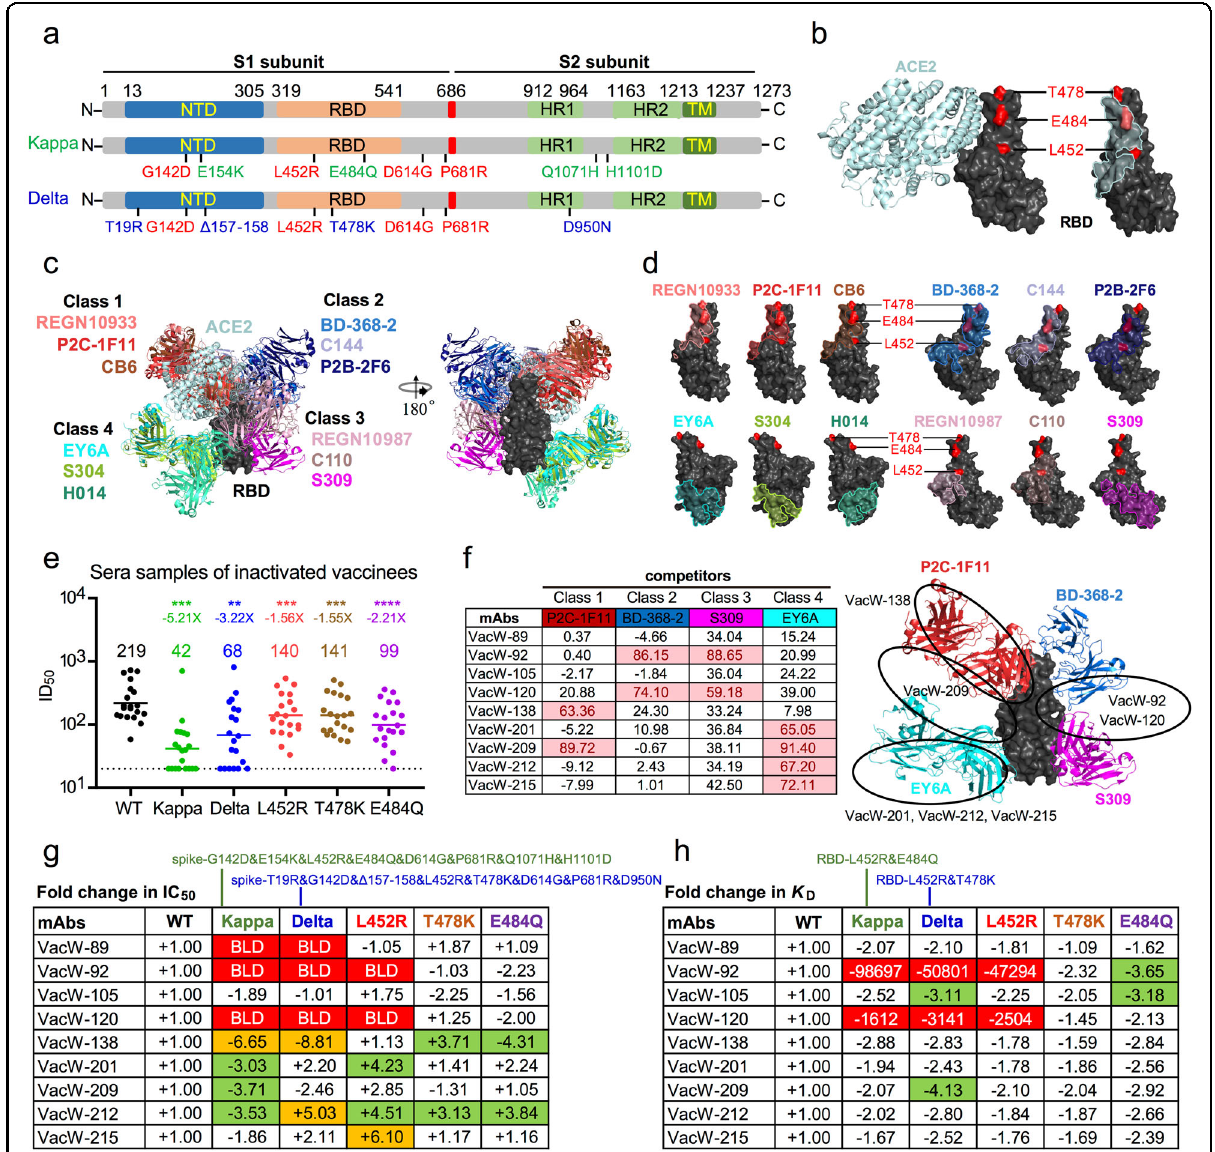
Fig. 1 Neutralization of SARS-CoV-2 Kappa and Delta variants by inactivated vaccine-elicited serum and monoclonal antibodies. a Mutations located in the viral spike proteins were identi fi ed in the Kappa and Delta variants. Shared mutations in both were highlighted in red, unique mutations in Kappa were marked in green, and mutations in Delta were in blue. b Overall structure of ACE2 in complex with SARS-CoV-2 RBD (left) and footprint of ACE2 on the RBD (right). Three mutation residues (L452, T478, and E484) were shown in red on the RBD. c Structural depiction of ACE2 and representative nAbs from each class binding to the RBD. Class 1: P2C-1F11, REGN10933, CB6; Class 2: BD-368-2, C144, P2B-2F6; Class 3: S309, C110, REGN10987; Class 4: EY6A, S304, H014. d Footprints of four classes of representative nAbs on the RBD. Three mutation residues (L452, T478, and E484) were shown in red on the RBD. e Changes in serum neutralizing titers of inactivated vaccine recipients against Kappa and Delta, as well as L452R, T478K, and E484Q variants, compared with WT. GMTs in ID 50 values were calculated and shown above each variant. ** P < 0.01, *** P < 0.001, **** P < 0.0001. f Competition ELISA (left) and predicted recognizing epitopes (right) of tested monoclonal nAbs binding to RBD with four representative nAbs. The values of competition measured in the highest concentration (10 μ g/mL) over 50% were highlighted in light red. g The fold change in IC 50 values of each monoclonal nAbs against mutant and WT viruses. h The fold change in af fi nity values in binding capacities of each nAb to mutant and WT RBD proteins. Data shown in e – h were means of two or three independent experiments. The changes shown in g , h between 3-fold and 5-fold were marked in green, between 5-fold and 10-fold were in orange. Below the limit of detection (BLD) in red indicated that the inhibition of nAbs was < 50% even in the highest concentration (50 μ g/mL), and changes in af fi nities more than 10-fold were also highlighted in red. Symbol ‘ + ’ indicates increased neutralization or af fi nity, and ‘–’ indicates decreased neutralization or af fi